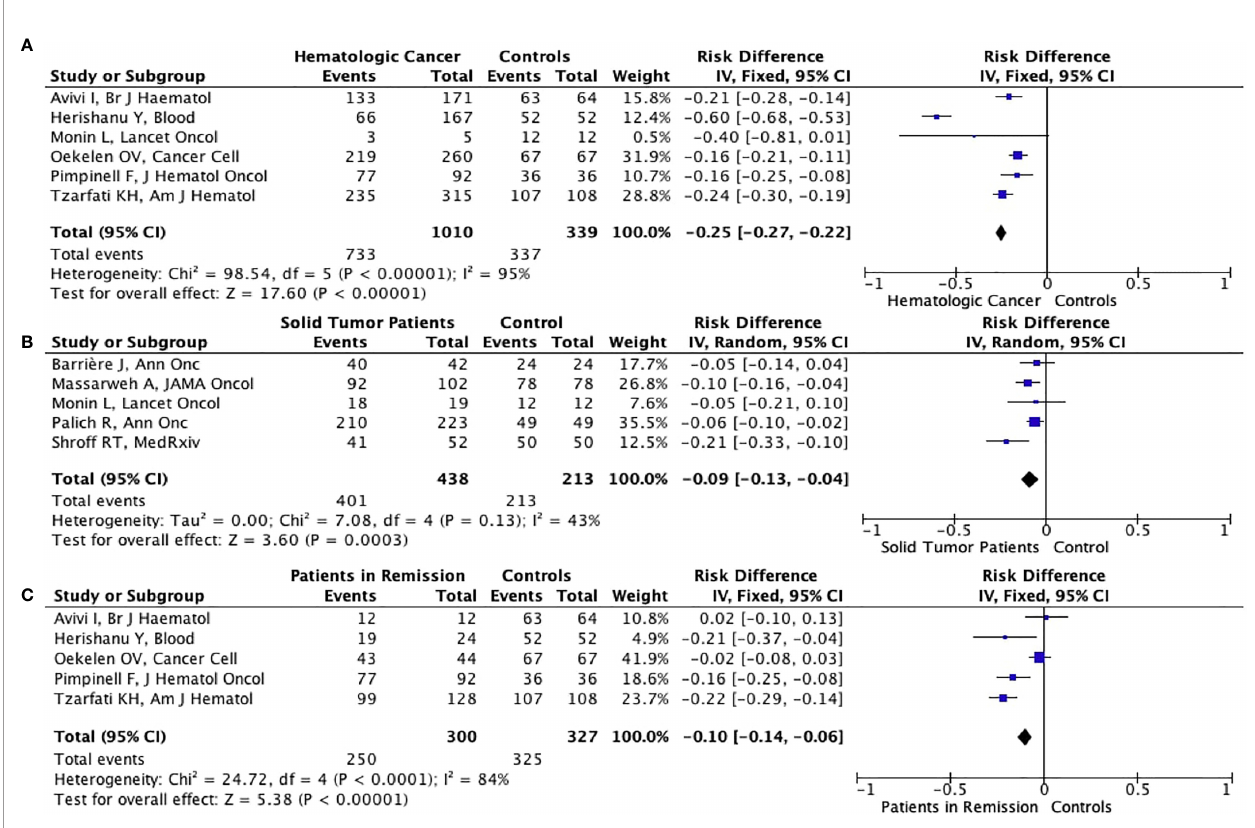
FIGURE 5ABC | Forest plot illustrating the risk differences of seroconversion rates between patients with hematologic malignancies (A) , solid tumors (B) or patients in remission (C) and healthy controls after second dose of